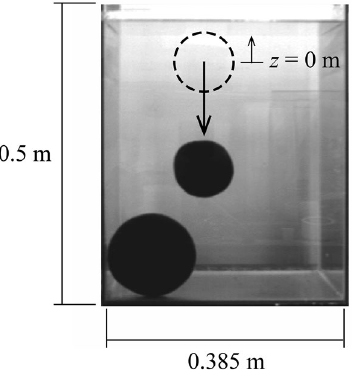
Figure 6. Underwater drop test of a Marimo to estimate its drag coefficient.